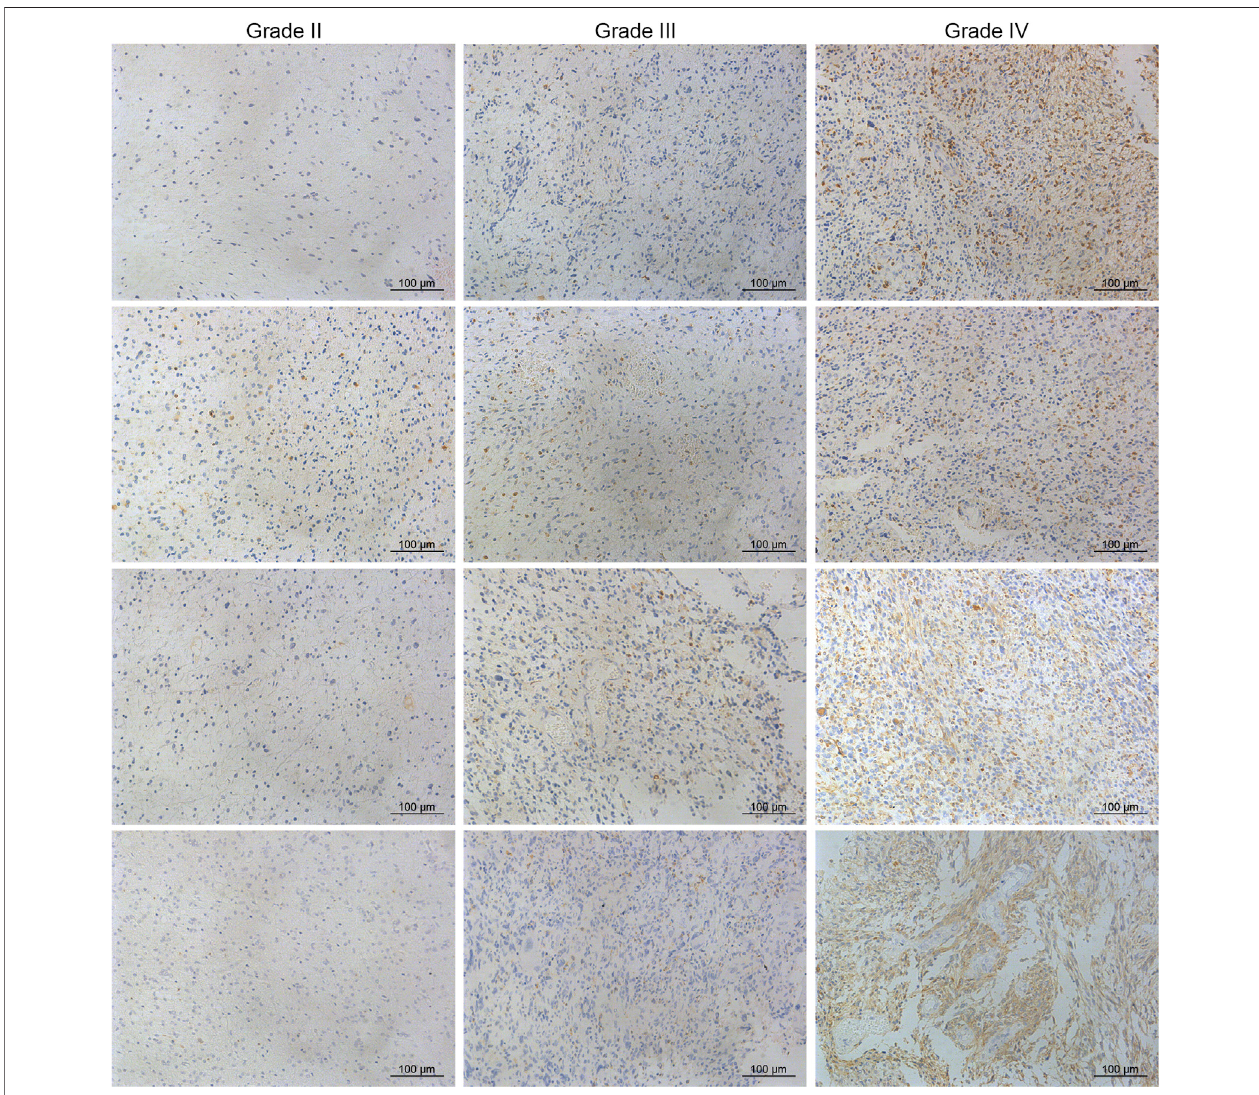
FIGURE 2 | Immunohistochemistry of CD74 in different grades of gliomas.